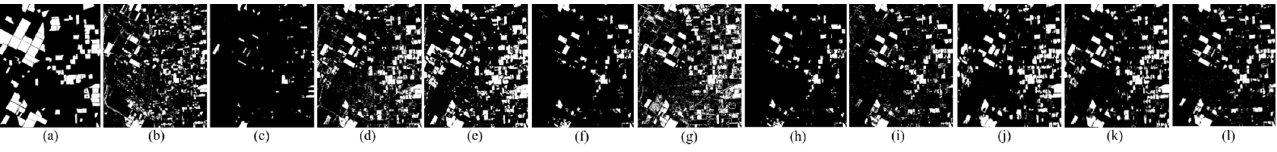
Figure 8. Binary detection results in the Bay Area dataset: ( a ) ground truth, ( b ) LSCD, ( c ) ASCD, ( d ) HOSVD, ( e ) TDRD, ( f ) PCANet, ( g ) DSFANet, ( h ) HI-DRL, ( i ) SSTN, ( j ) UTT-SVD, ( k ) UTT-noSVD, and ( l ) STT.